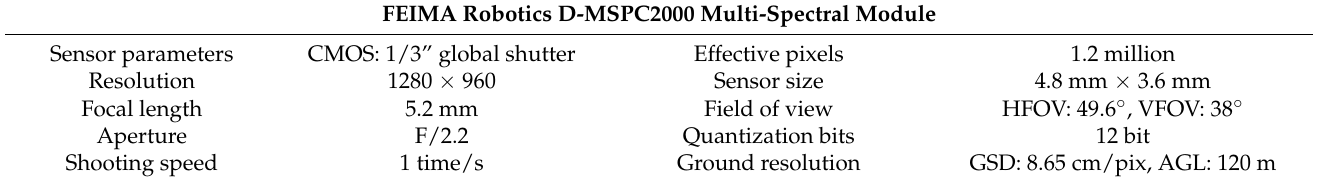
Table 5. Parameters of multi-spectral data